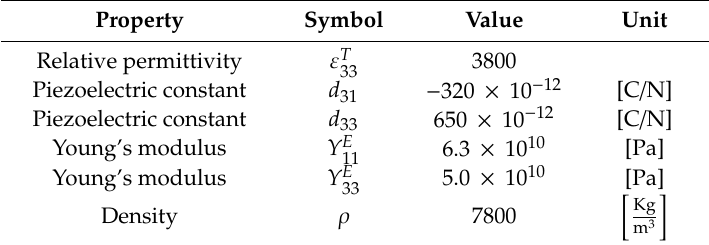
Table A2. PZT 5H properties.